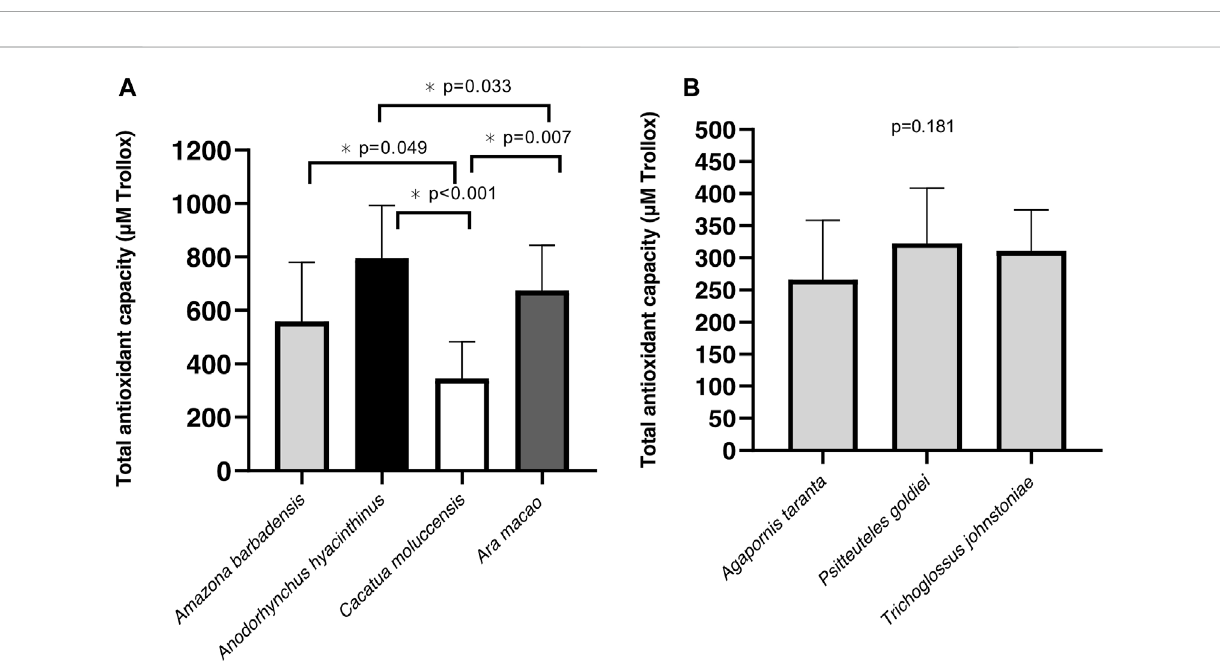
FIGURE 4 Markers of oxidative stress. (A) Total antioxidant capacity (mean of µM Trolox equivalents ±SD) in long-vs. short-lived psittacine. (B) Lipid peroxidation products (mean ofµM MDA ±SD) inlong-vs.short-lived psittacine. A two-way ANOVA was conducted to determine theeffects of longevity and